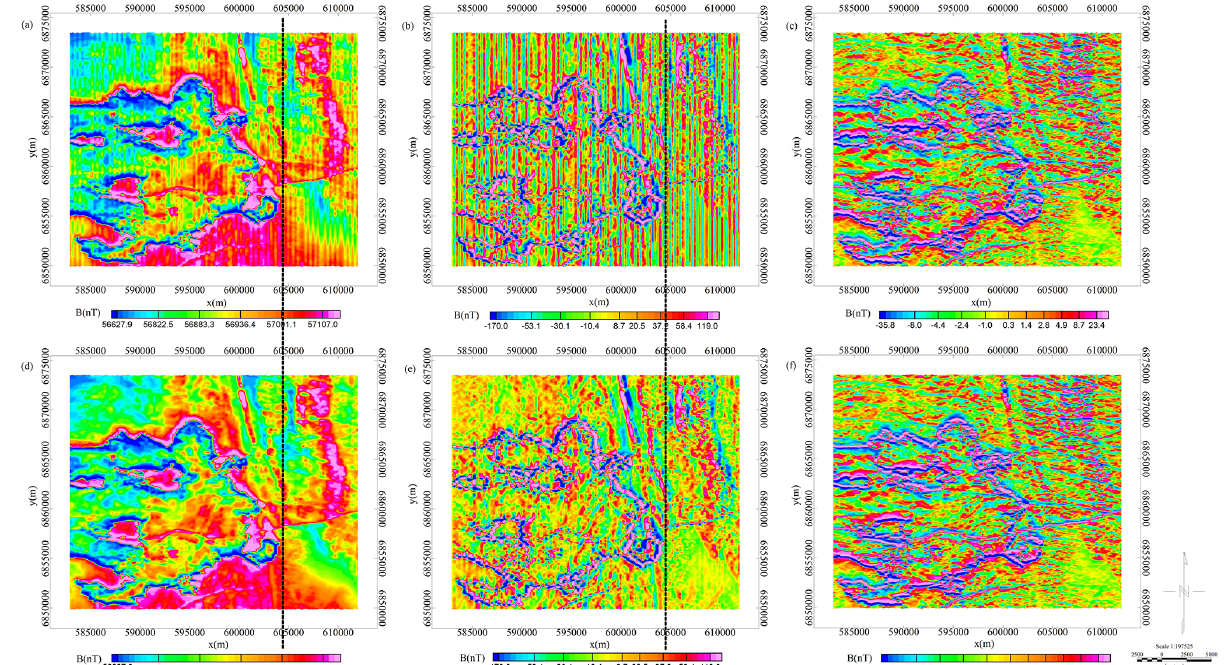
Figure 1. The directional property of leveling error. (a) The raw magnetic data. (b) The horizontal gradients of the raw magnetic data. (c) The vertical gradients of the raw magnetic data. (d) The leveled magnetic data. (e) The horizontal gradients of the leveled magnetic data. (f) The vertical gradients of the leveled magnetic data.